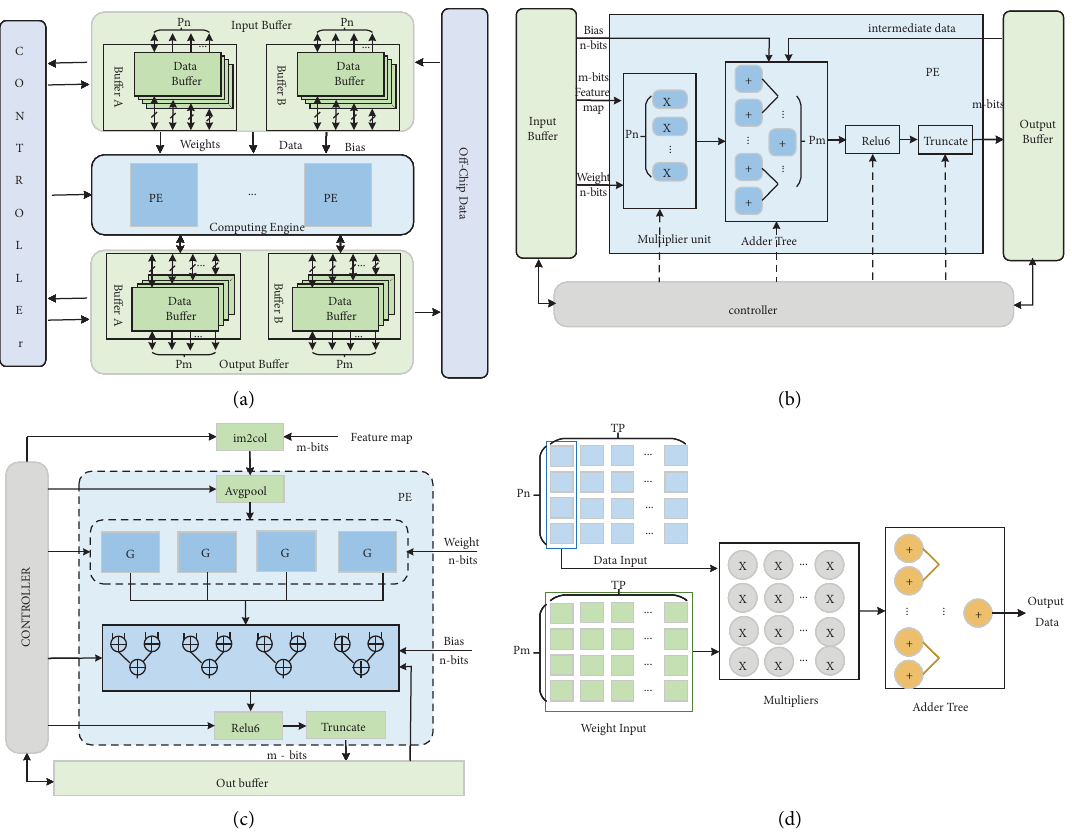
Figure 5: Convolution computing engine. (a) Bufer design. (b) Computing engine design for DWC. (c) Computing engine design for PWC. (d) Te processing element of general matrix multiplication